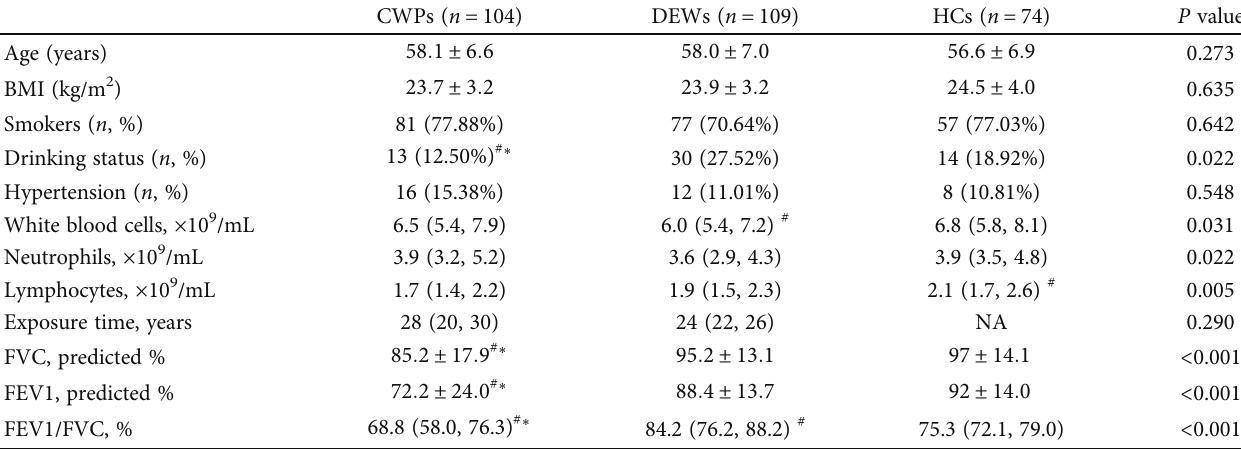
Table 1: Participants ’ characteristics.